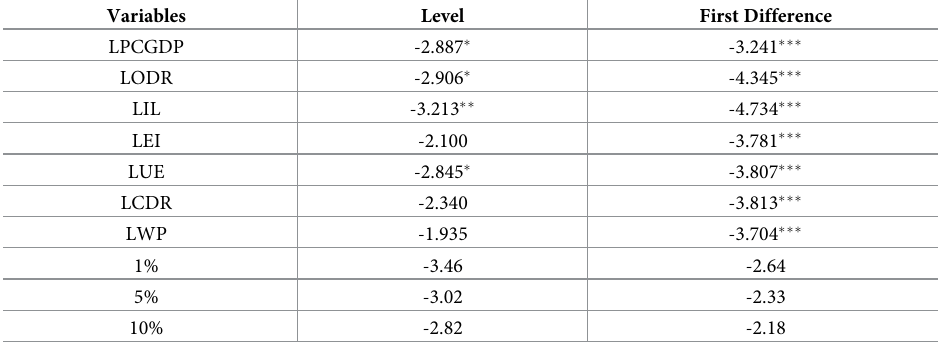
Table 10. CIPS unit root test of central region of